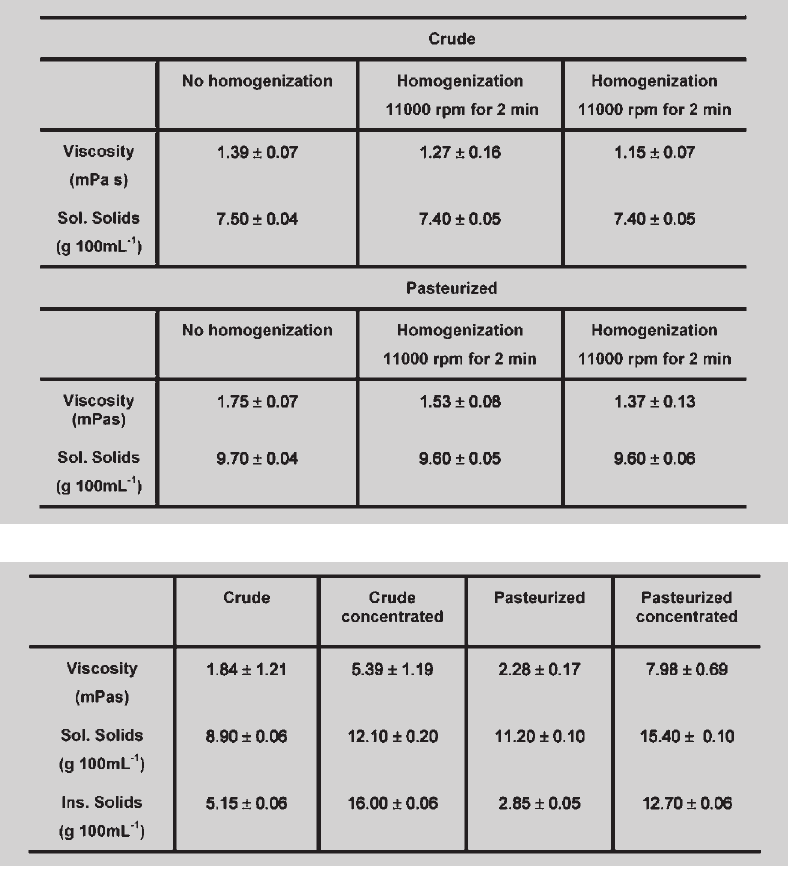
Figure 6 (right): Rheological behavior of the filtrated and non-filtrated pasteurized